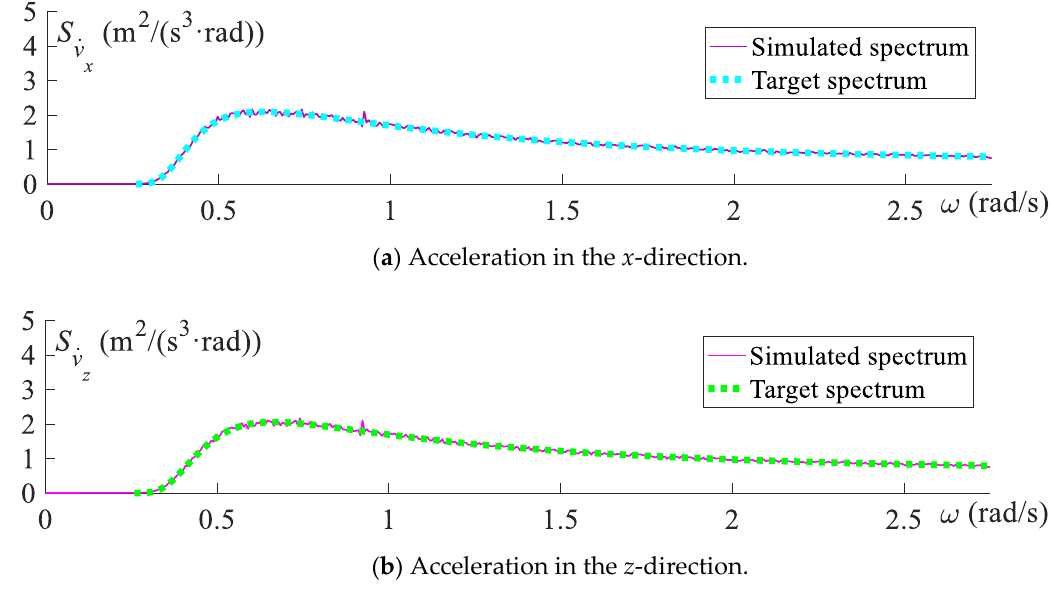
( b ) Acceleration in the z -direction. Figure 6. Power spectrum density functions of wave–particle accelerations at a still water level ( z = 0).